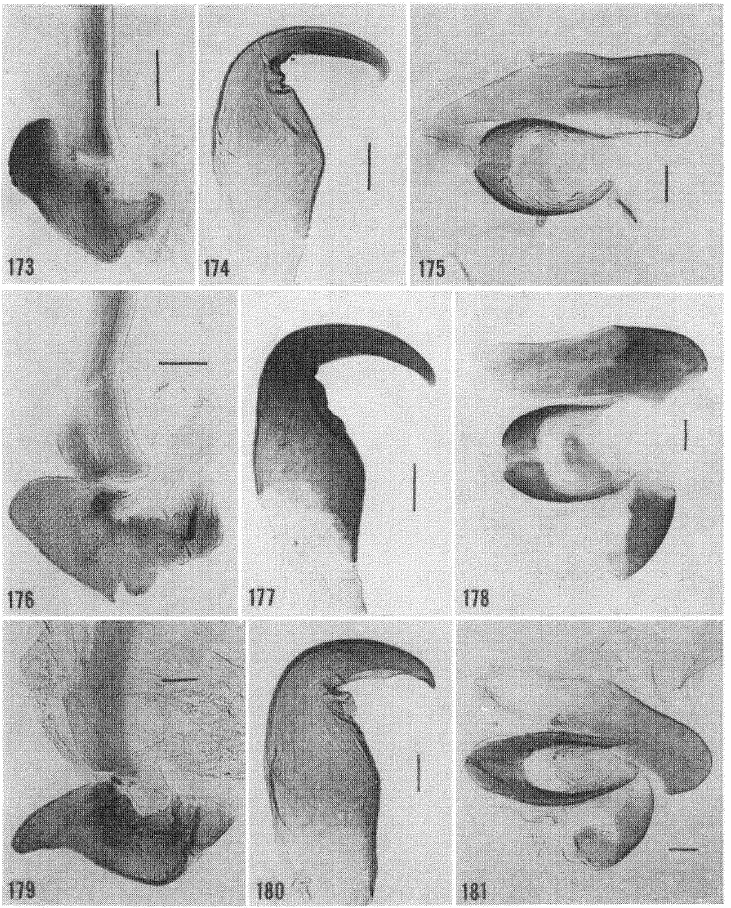
Figures 173-181. Male genital phallomeres of Derocalymma spp. 173- 178. (1415 L). D. lampyrina. Okavan,go, Runtu, S.W. Africa (det. Princis). 176-178. (37 CUZM). (from shown in Fig. 161). 179-181. (141 ANSP). D. sp. German East Africa (from shown in Fig. 162). (scale---0.1